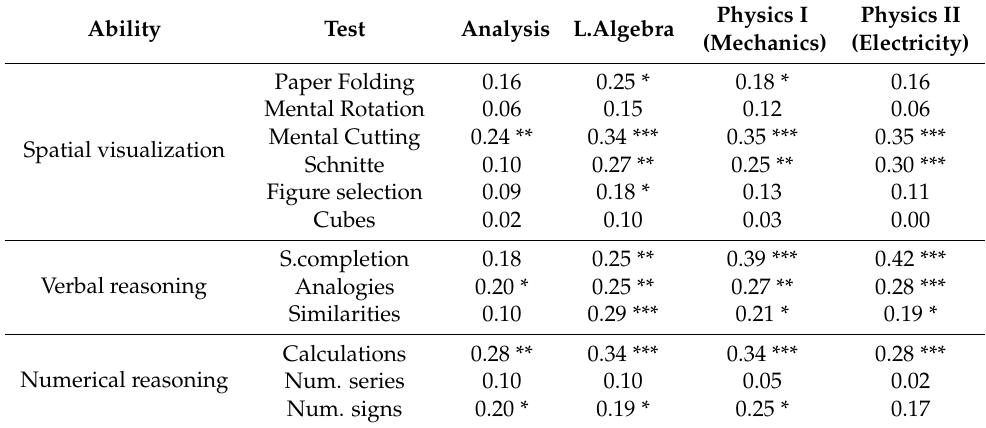
Table 6. Correlations between ability measures and grades among math-physics students ( N = 167).